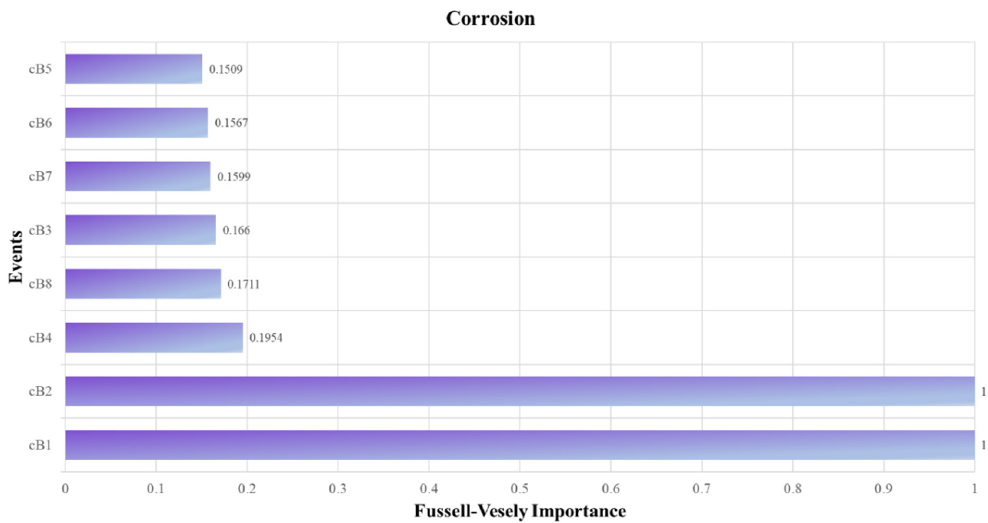
Figure 4. Fussell–Vesely Importance of each basic event of collapse accident.